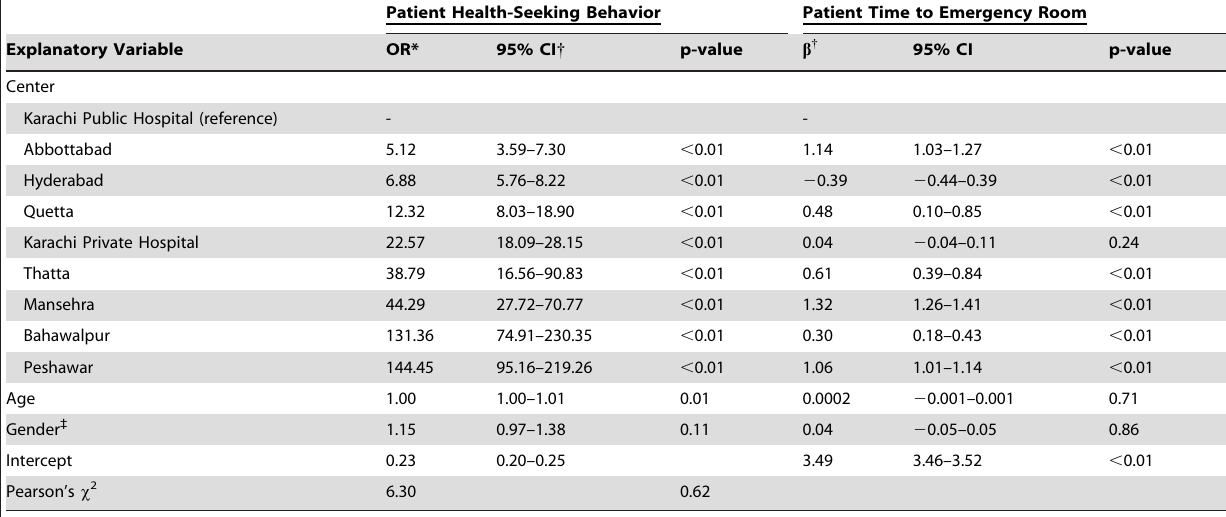
Table 3. Results of multiple logistic regression analysis of dog-bite patient health-seeking behavior and multiple linear regression analysis of travel times to emergency rooms in Pakistan (Feb 2009–Feb 2011).